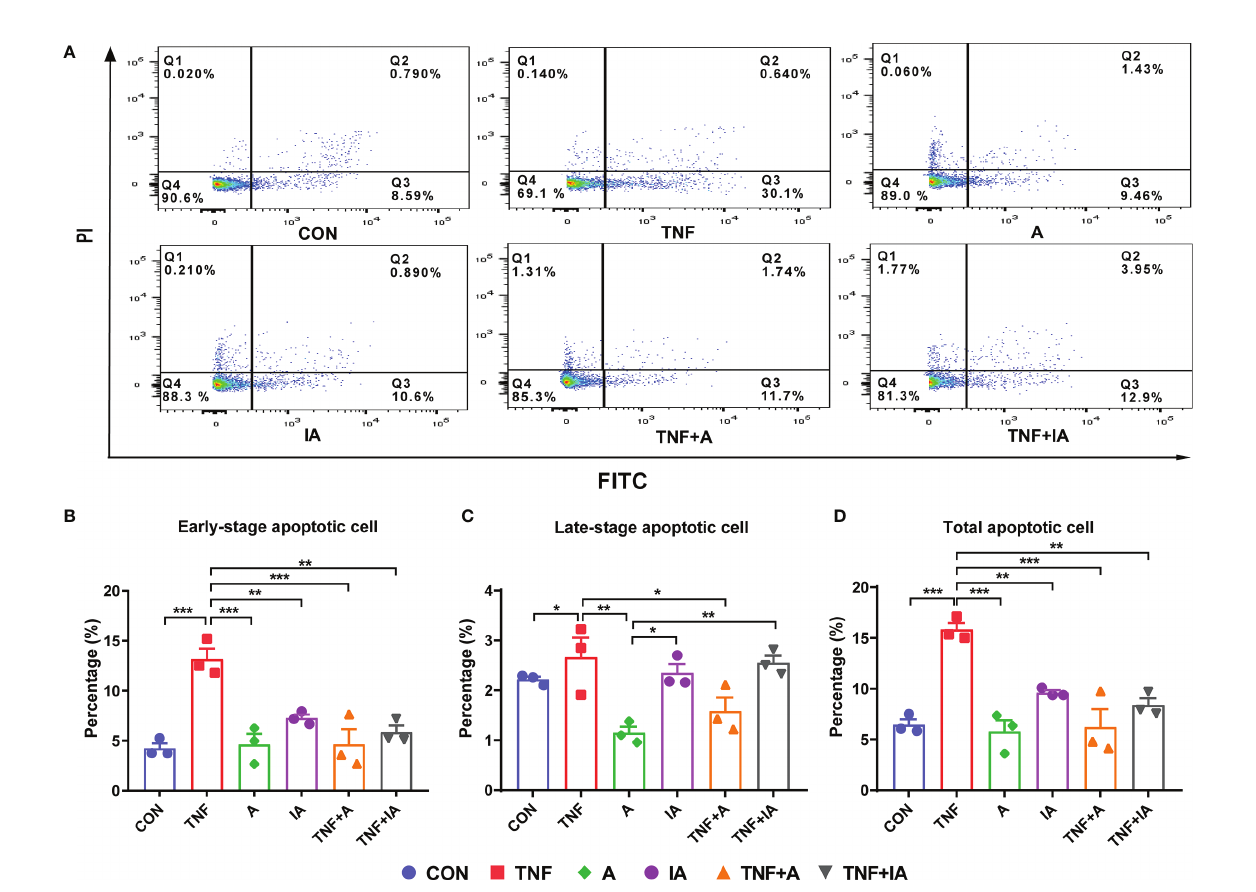
FIGURE 5 | The apoptosis of IPEC-J2cells in different groups. (A) The pro fi le of fl ow cytometry with an annexin V-FITC/PI kit of the IPEC-J2 cells in different groups. Each of the frames is divided into four quadrants: Q1, necrotic cells. Q2, cells in the late-stage of apoptosis. Q3, cells in the early-stage of apoptosis. Q4, normal cells. (B) The rate of IPEC-J2 cells in the early stage of apoptosis in different groups. (C) The rate of IPEC-J2 cells in the late stage of apoptosis in different groups. (D) The rate of total apoptosis of IPEC-J2 cells in different groups. Data are represented as mean± SEM (n = 3). * P < 0.05, ** P < 0.01, *** P < 0.001. CON, cells treated with PBS for 48 h. TNF, cells challenged with 20 ng/mL Recombinant Susscrofa TNF- a for 48 hours. A, cells co-cultured with 10 8 copies/mL active A. muciniphila for 48 h. IA, cells co-cultured with 10 9 copies/mL inactive A. muciniphila for 48 h. TNF+A, cells challenged with 20 ng/mL TNF- a for 40.5 h and then co- cultured with 10 8 copies/mL active A. muciniphila for 7.5 h. TNF+IA, cells challenged with 20 ng/mL TNF- a for 40.5 h and then co-cultured with 10 9 copies/mL inactive A. muciniphila for 7.5